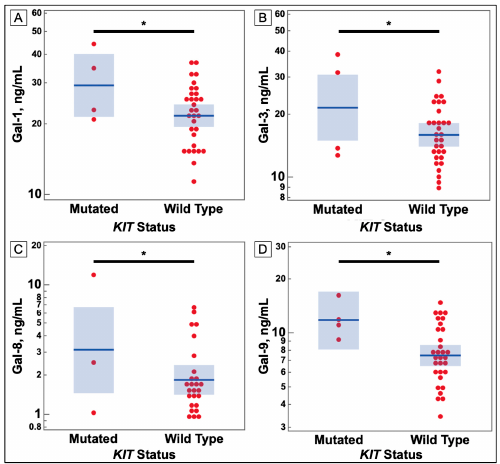
Figure 3. Comparison of Serum Galectin Levels of Breast Cancer Patients KIT Gene Mutation Status in Tumor Sample. ( A ) Serum levels of galectin-1, as determined by ELISA, were significantly higher in breast cancer patients with a mutation in the KIT gene. ( B ) Serum levels of galectin-3, as deter- mined by ELISA, were significantly higher in breast cancer patients with a mutation in the KIT gene. ( C ) Serum levels of galectin-8, as determined by ELISA, were significantly higher in breast cancer patients with a mutation in the KIT gene. ( D ) Serum levels of galectin-9, as determined by ELISA, were significantly higher in breast cancer patients with a mutation in the KIT gene. (* p -value ≤ 0.05).